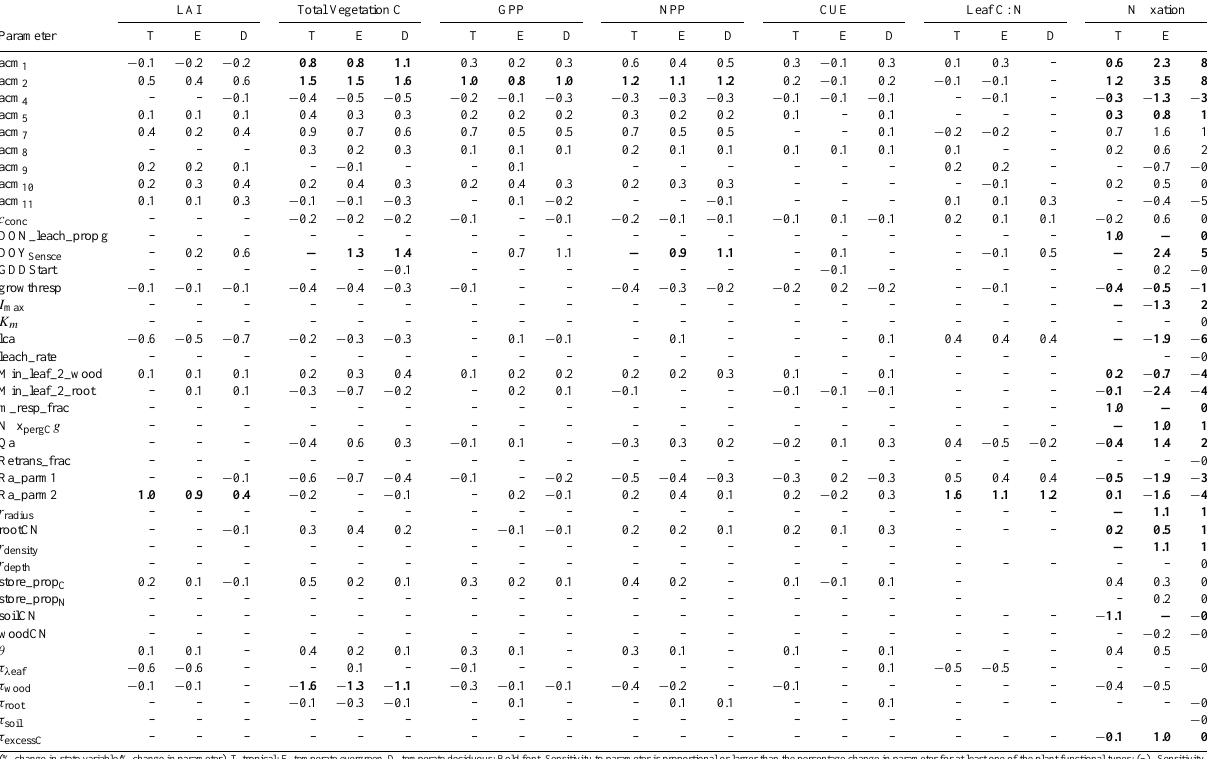
Table 8. Sensitivity metric ( S ) of key state variables to parameters in ACONITE for three ecosystem types (T, E, D) . Only parameters with | S | ≥ 0.1 are